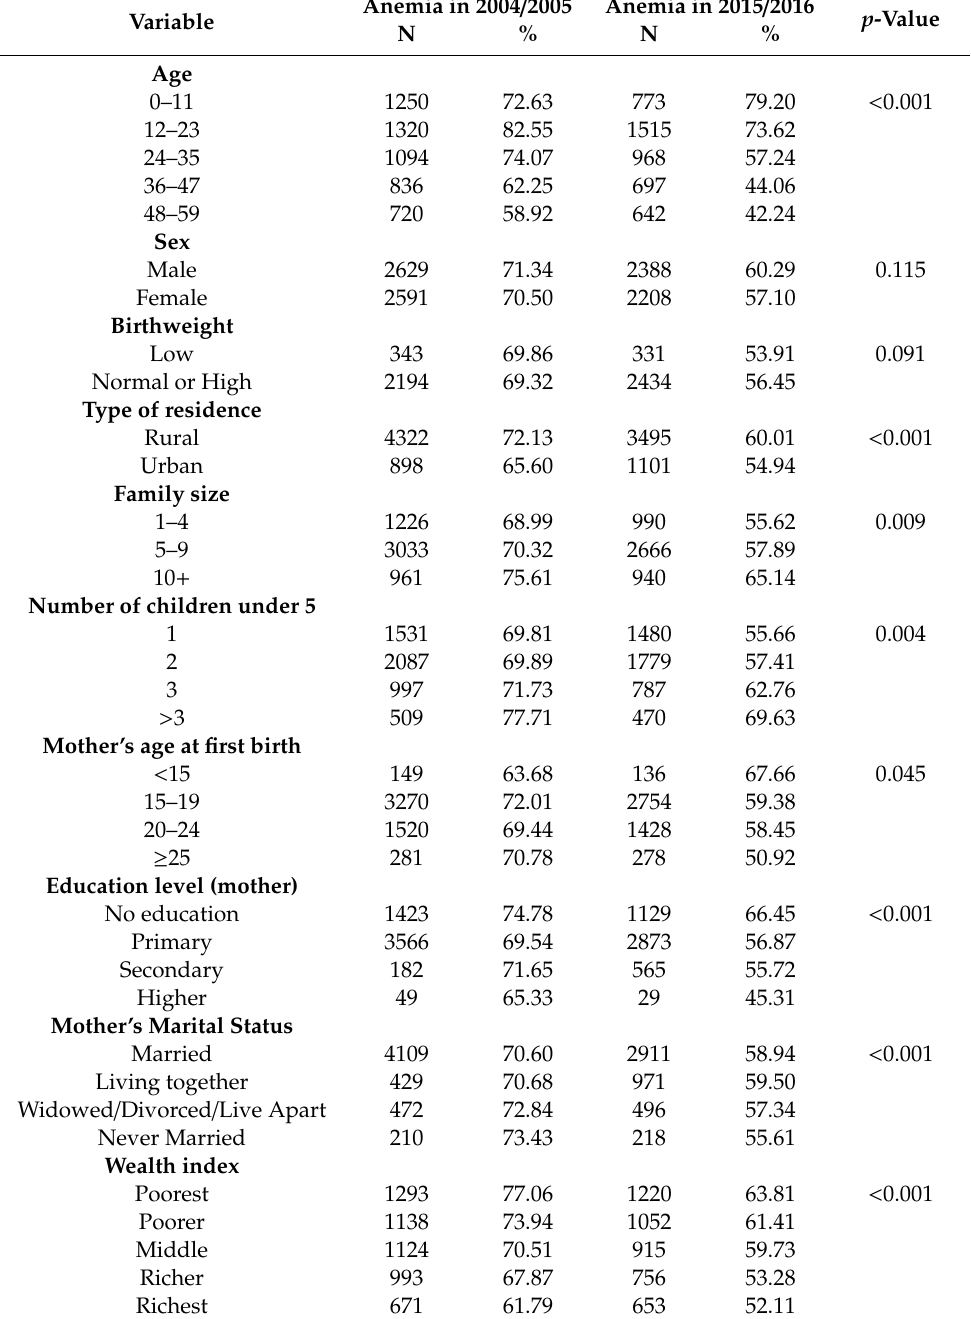
Table 2. Individual and household characteristics in relation to changing burden of anemia among children under five in